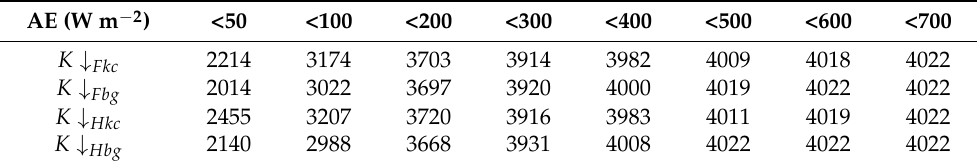
Table 4. Statistical errors for global solar irradiance by Holtslag’s (H) [5] and Foken’s (F) [11] clear sky irradiance calculations, together with both methods for including cloudiness using the Kasten and Czeplak (kc) [39] and Burridge and Gadd (bg) [40] methodologies. BIAS MAE RMSE Correlation Coefficient ( r ) Method [W m − 2 ] [W m − 2 ] [W m − 2 ] K ↓ Fkc +5 71 109 0.90 K ↓ Fbg +8 74 108 0.91 K ↓ Hkc − 12 69 109 0.91 K ↓ Hbg − 10 77 111 0.91 (0.85, 0.80) Table 5. The total number of situations with absolute errors (AE) fewer than 50, 100, . . . , 700 W m − 2 . AE (W m − 2 ) <50 <100 <200 <300 <400 <500 <600 <700 K ↓ Fkc 2214 3174 3703 3914 3982 4009 4018 4022 K ↓ Fbg 2014 3022 3697 3920 4000 4019 4022 4022 K ↓ Hkc 2455 3207 3720 3916 3983 4011 4019 4022 K ↓ Hbg 2140 2988 3668 3931 4008 4022 4022